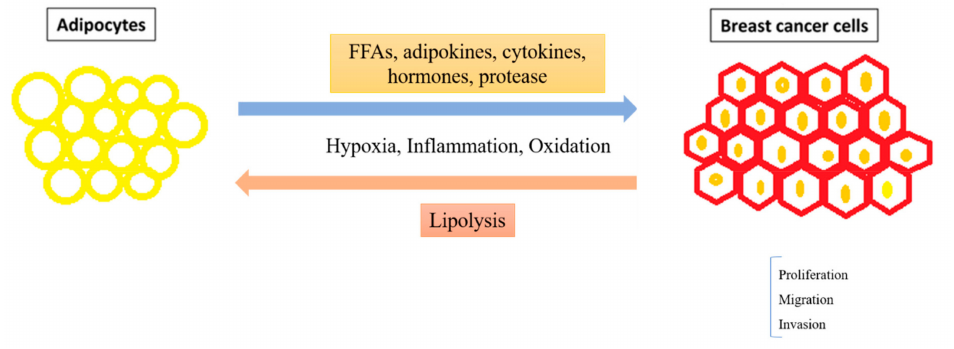
Figure 1. Adipocytes regulation of breast